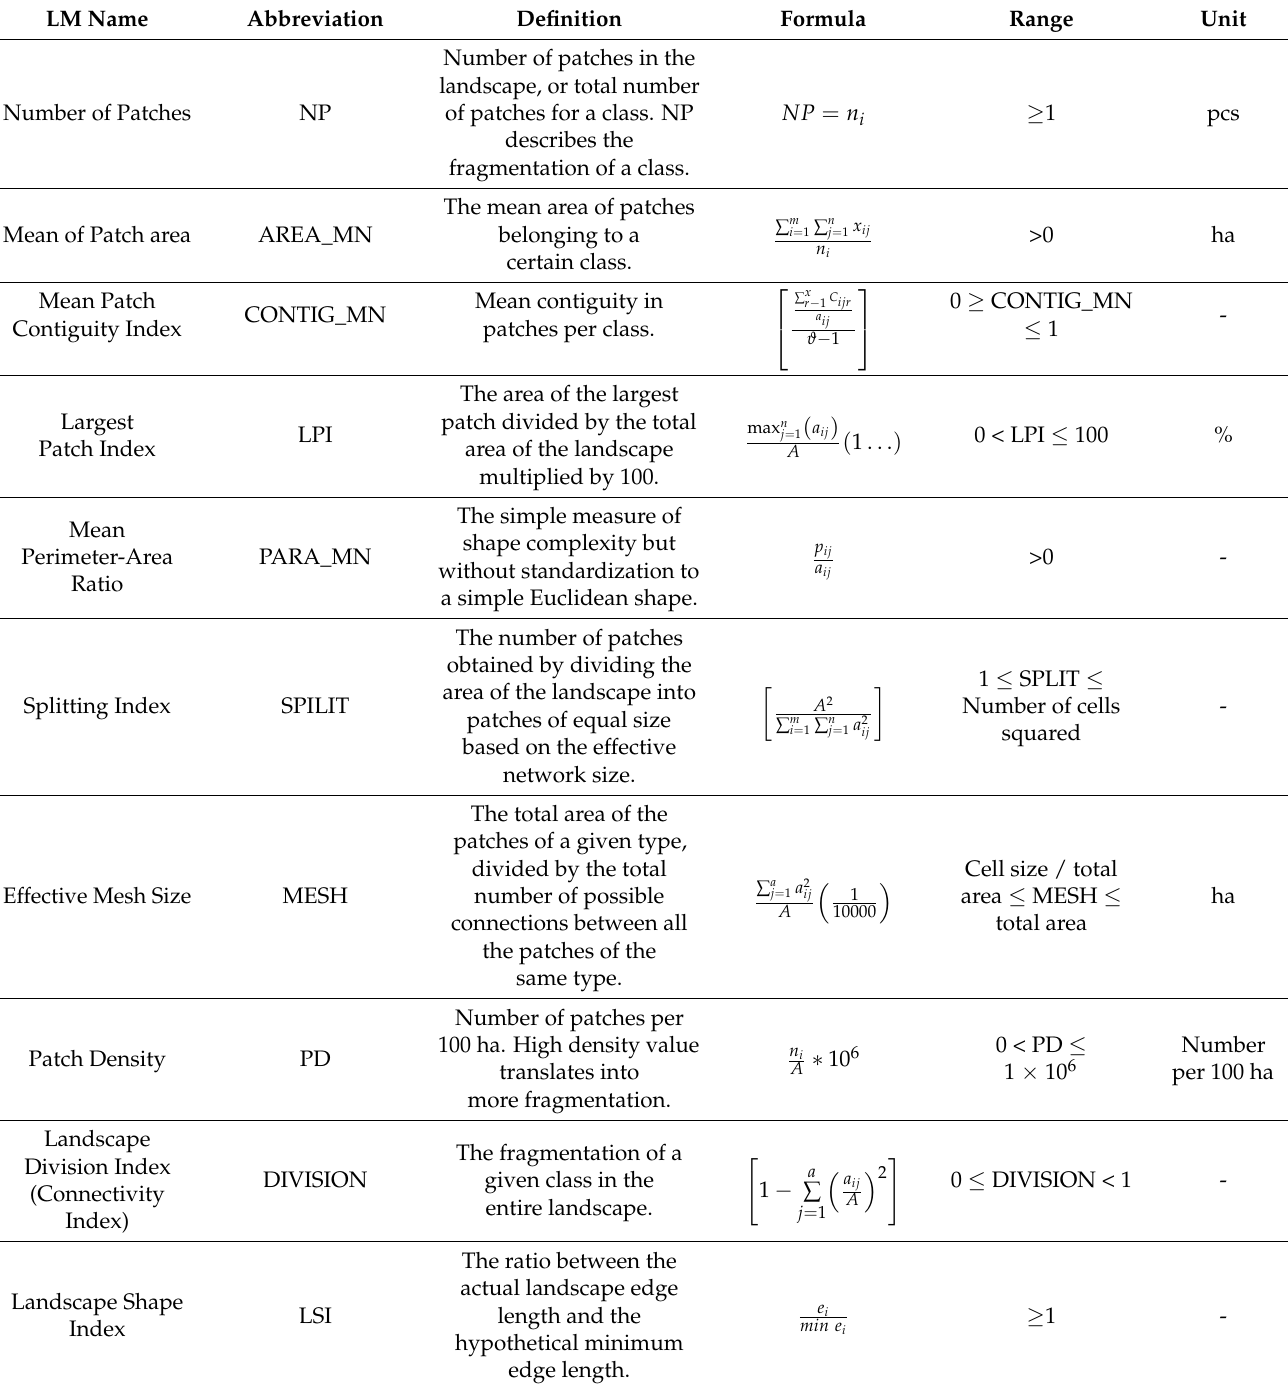
Table 2. Description of the landscape metrics (LMs) selected for this